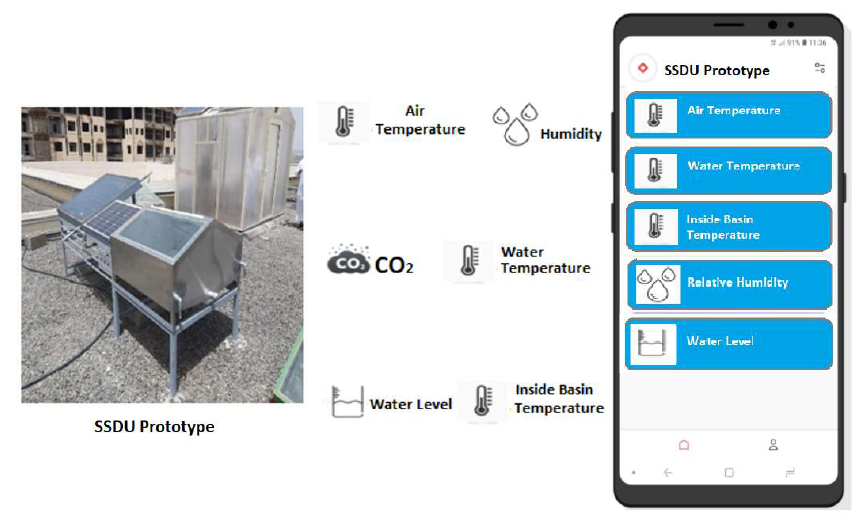
Figure 11. The main Android app screen for the designed smart solar still desalination unit.